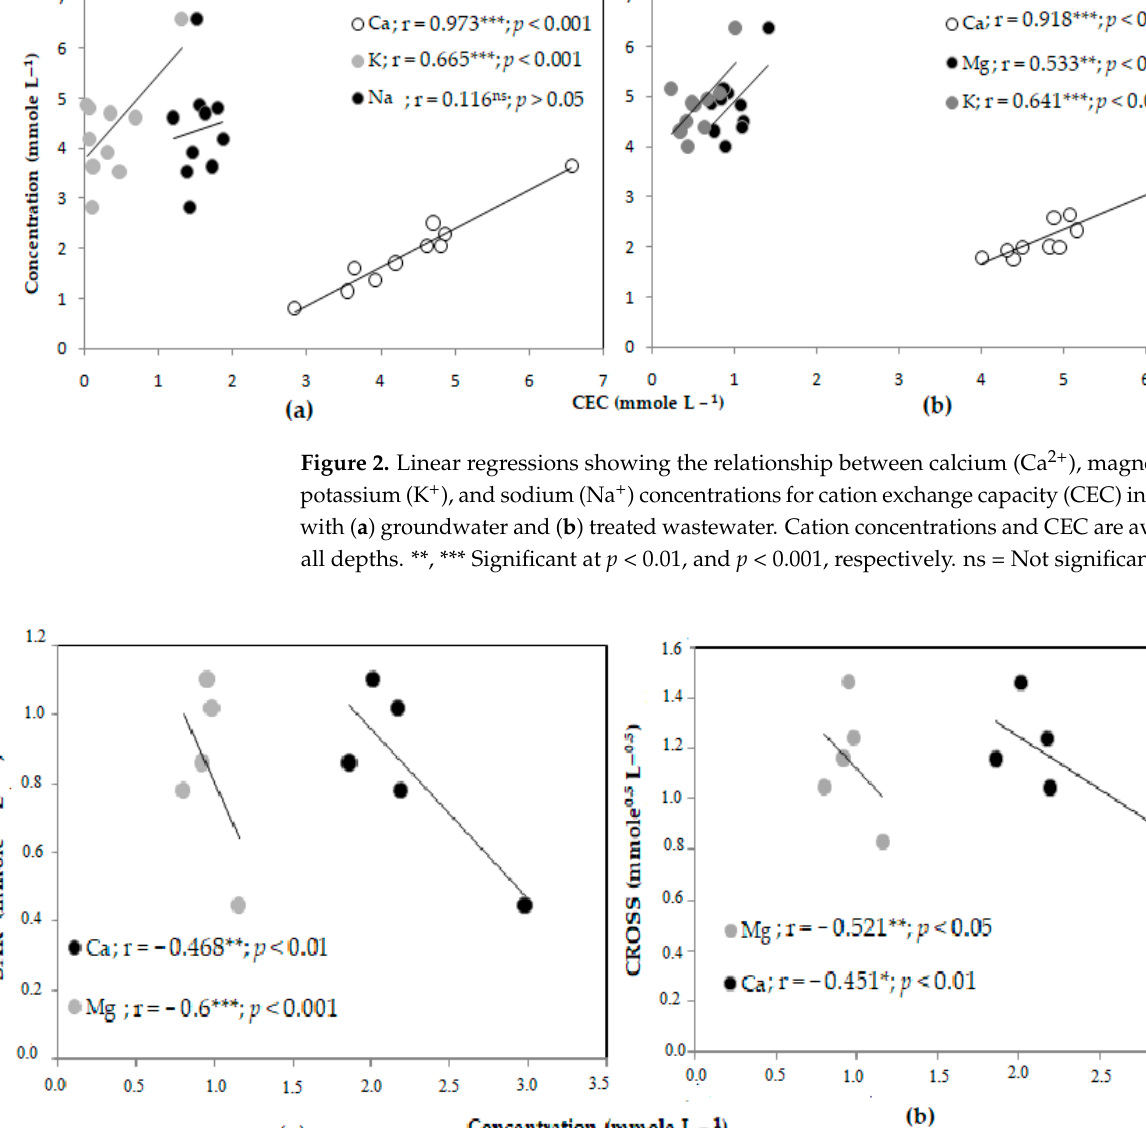
Figure 4. Linear regression showing the relationship between magnesium (Mg 2+ ) and potassium (K + ) concentrations in groundwater irrigated soils. Mg 2+ and K + concentrations are across the two areas of study and averaged across all five depths. ** Significant at p < 0.01. 4. Discussion 4.1. Effects of TWW and Application Period on Physicochemical Properties Irrigation with treated wastewater significantly altered all the physicochemical pa ‐ rameters. In the current study, the TWW period only had an impact on the soil pH. In ‐ deed, compared to irrigation period of 20 years, soil pH increased after 38 years of wastewater application. This increase might be ascribed to processes such denitrification [21], which requires one mole of H + for every mole of denitrified NO 3 ‐ and decarboxyla ‐ tion and deamination (organic anions and amino acids) activities that use protons [22]. Previous studies [23,24] have also reported increased soil pH with wastewater irrigation. In addition, according to Hidri et al. [25], the increase in pH after long ‐ term TWW ap ‐ plication could be explained by the modification in the bacterial community structure as a result of a decrease in abundance of Actinobacteria and an increase in abundance of Gammaproteobacteria, which is positively correlated to soil pH [26]. In contrast to TWW, the long ‐ term application of GW had altered all soil parameters except the pH. In fact, we